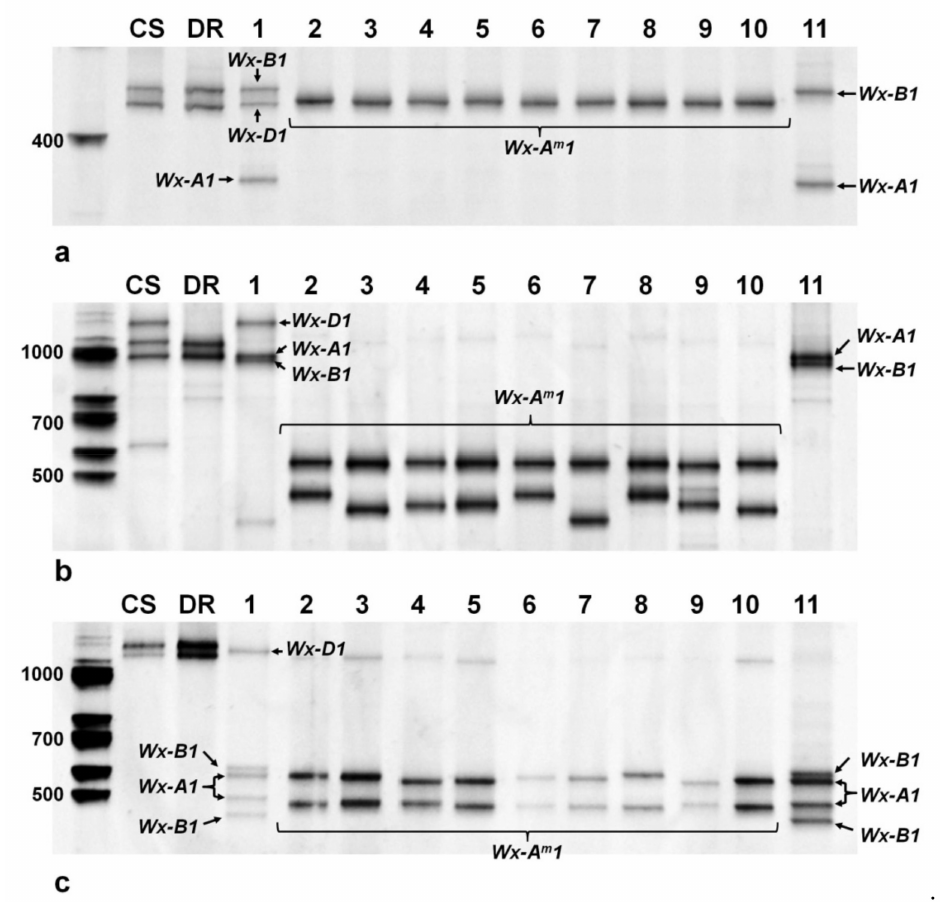
Figure 5. DNA digestion of PCR products from Wx alleles of the materials evaluated: ( a ) Wx1Fw/Wx1.3Rv fragment with Dde I; ( b ) Wx2Fw/Rv fragment with Dde I; and ( c ) Wx3Fw/Rv fragment with Nco I. Lanes are as follows: 1 , common wheat cv. Chinese Spring; 2 , PI 554559; 3 , PI 427622; 4 , PI 554548; 5 , PI 427453; 6 , PI 470720; 7 , PI 470713; 8 , PI 538544; 9 , PI 427804; 10 , PI 427629; and 11 , durum wheat cv. Don Ricardo. CS and DR , cv. Chinese Spring and cv. Don Ricardo without digestion.